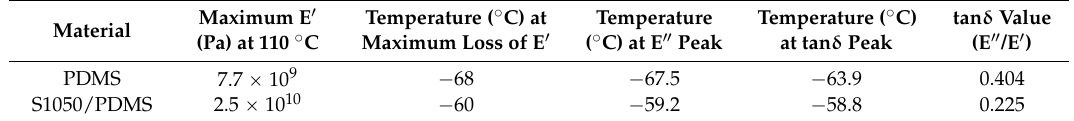
Figure 10. Dynamic mechanical properties in tensile mode of ( a ) PDMS and ( b ) S1050/PDMS composite film. The storage modulus value of S1050/PDMS composite increased and energy dissipation or damping factor decreased owing to formation of chemical bonds between the PDMS chains and armalcolite (Fe 2 MgTi 3 O 10 ) as well as calcium titanate (CaTiO 3 ) of ceramic (S1050) particles. Table 2. Dynamic mechanical properties of PDMS and S1050/PDMS